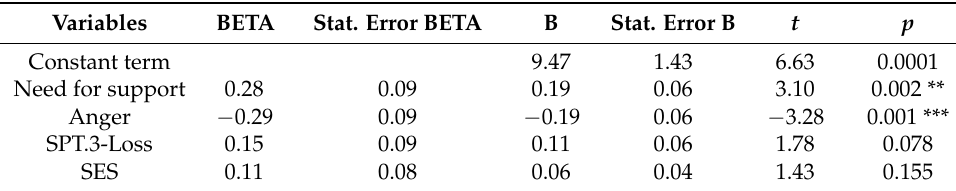
Table 5. Determinants of variables for the need for